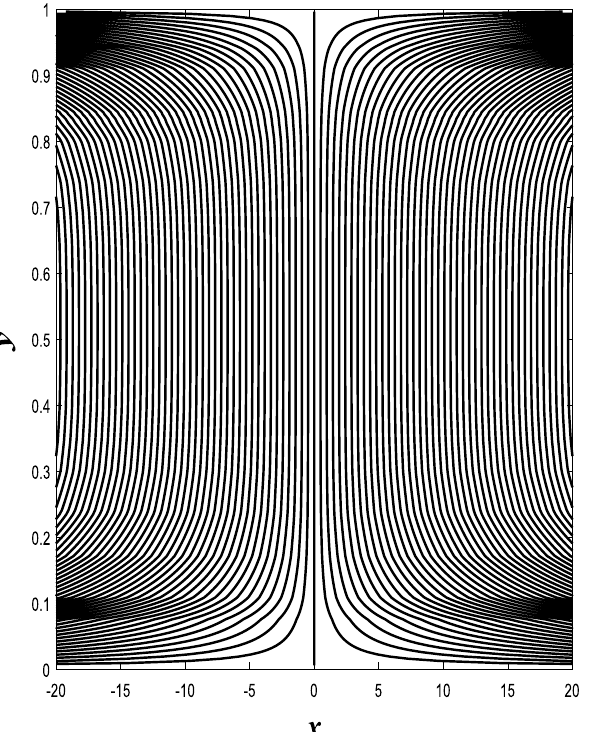
Figure 34. Stream lines profile at F = 1.2.